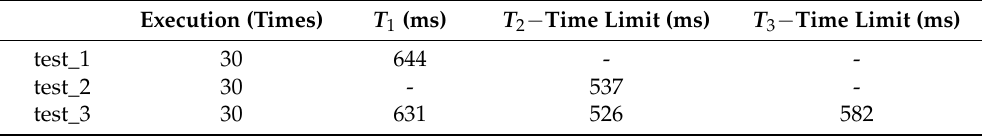
Table 3. Performance evaluation results for the coaching timing